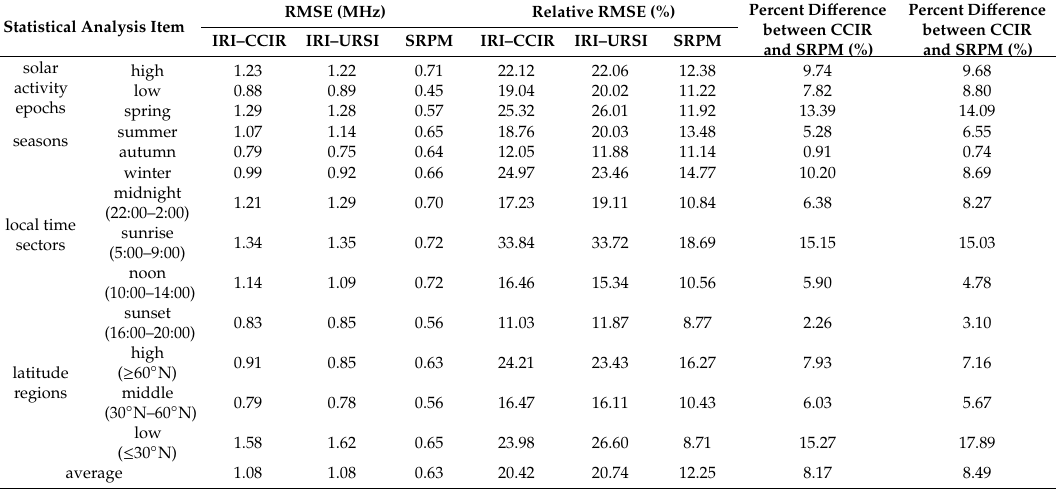
Table 2. RMSE and relative value between measured values of f o F 2 and predicted values of CCIR, URSI, and SRPM for two solar activity epochs, four seasons, four local time periods and three latitude regions. Statistical Analysis Item